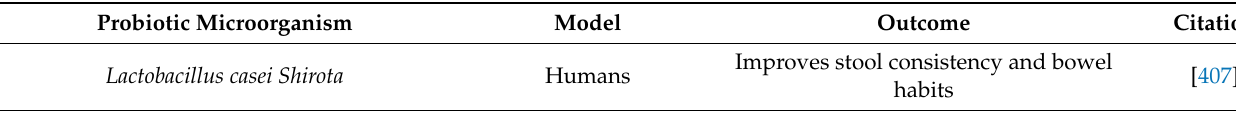
Table 4. Interactions of probiotic microbiota and their effects on the gut–brain